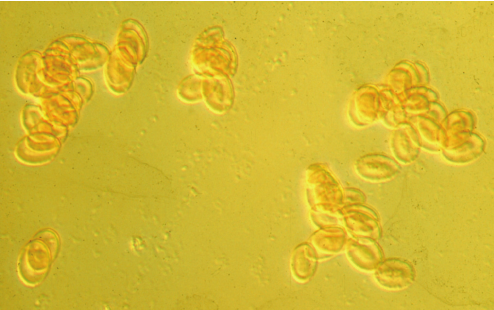
Figure 3: Positive antiglobulin reaction; red blood cells from an experimentally infected rainbow trout (reproduced from Woo